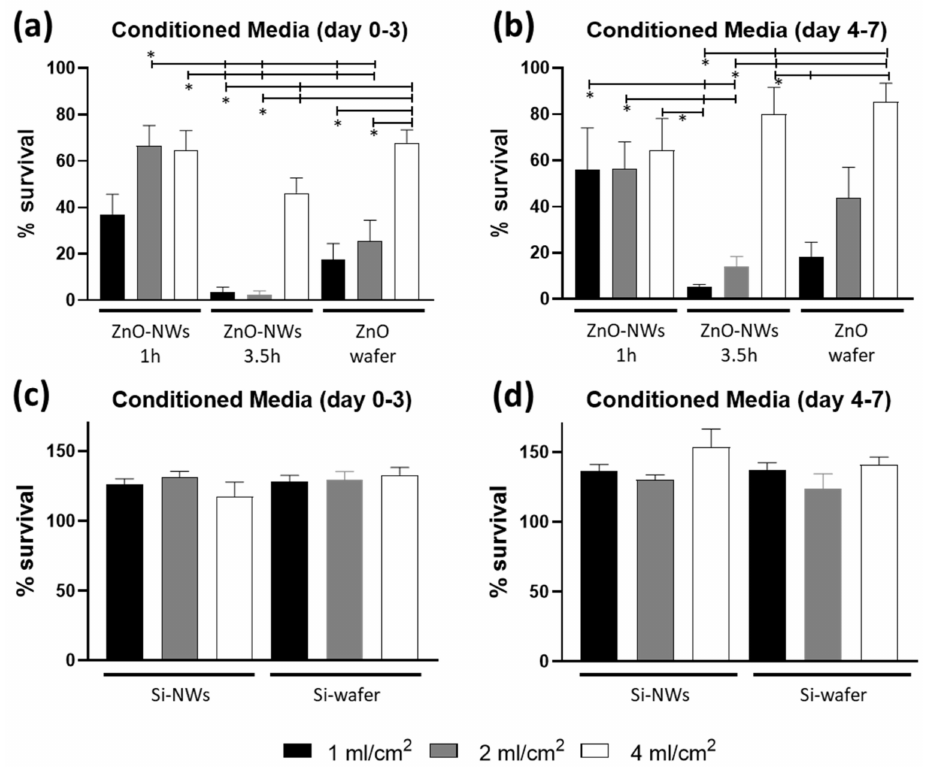
Figure 3. Cytotoxicity assay of ZnO- ( a , b ) or Si- ( c , d ) based substrate-conditioned media collected after 3 ( a , c ) and 7 days ( b , d ). * p ≤